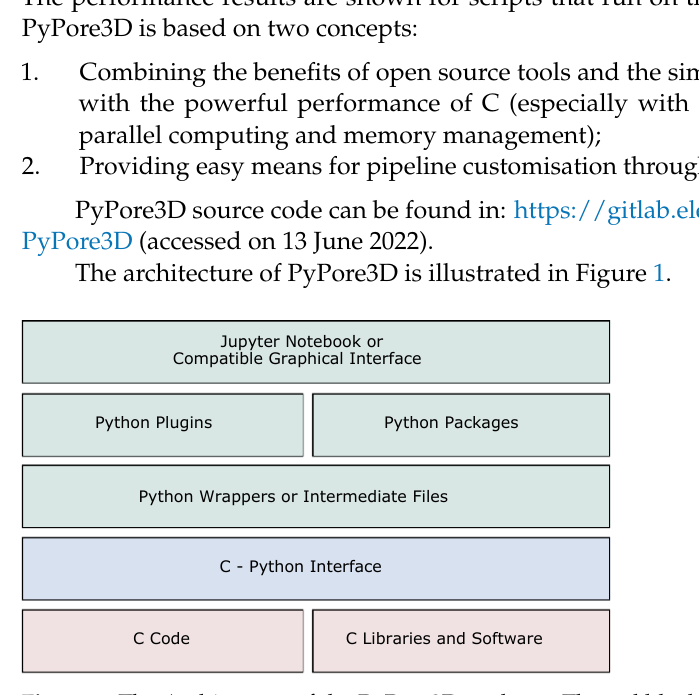
Figure 1. The Architecture of the PyPore3D package. The red blocks represent the Pore3D C code and illustrate that it can be extended with more C libraries. The green blocks represent the Python wrappers and show that it can be integrated with other Python packages and plugins. It can also be integrated with Jupyter Notebooks. The blue layer illustrates the binaries, which act as an interface that links the C and the Python